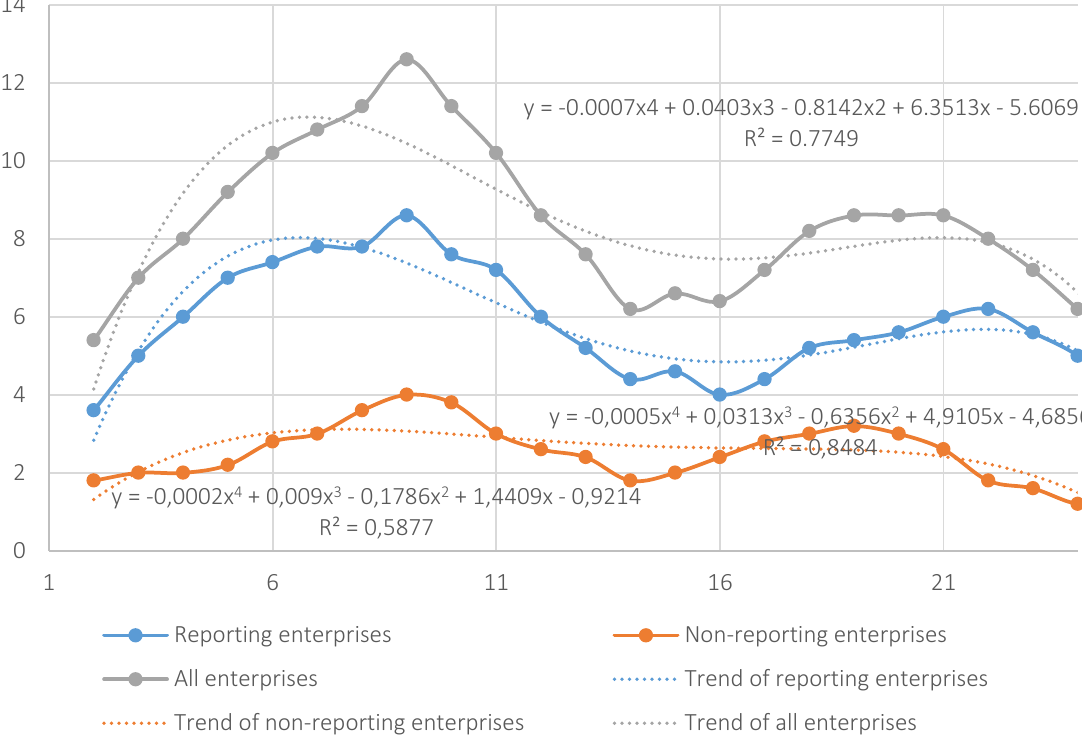
Figure 2. Trends modelled by 5-year moving average